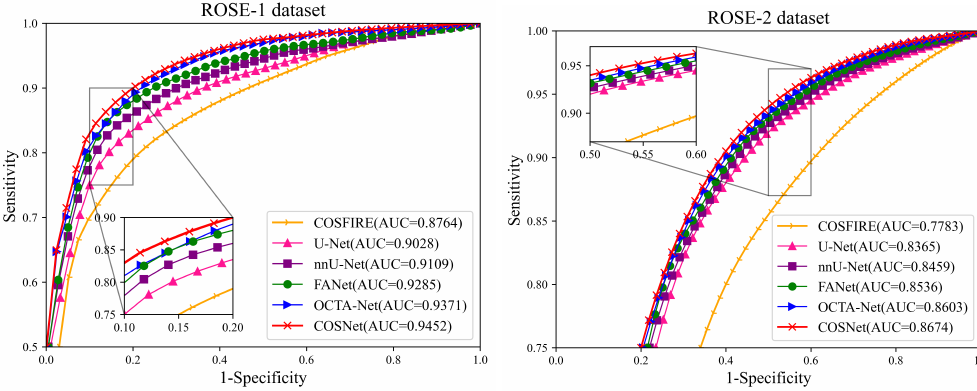
Figure 6. ROC curves for ROSE-1 ( left ) and ROSE-2 ( right ).